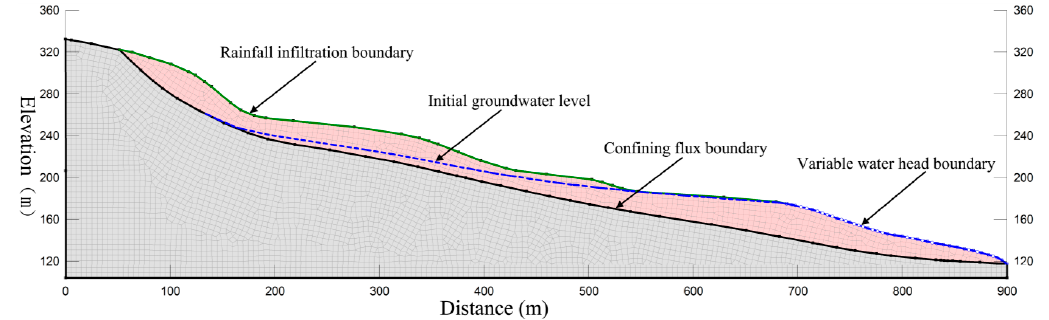
Figure 4. Main sliding section of the landslide.